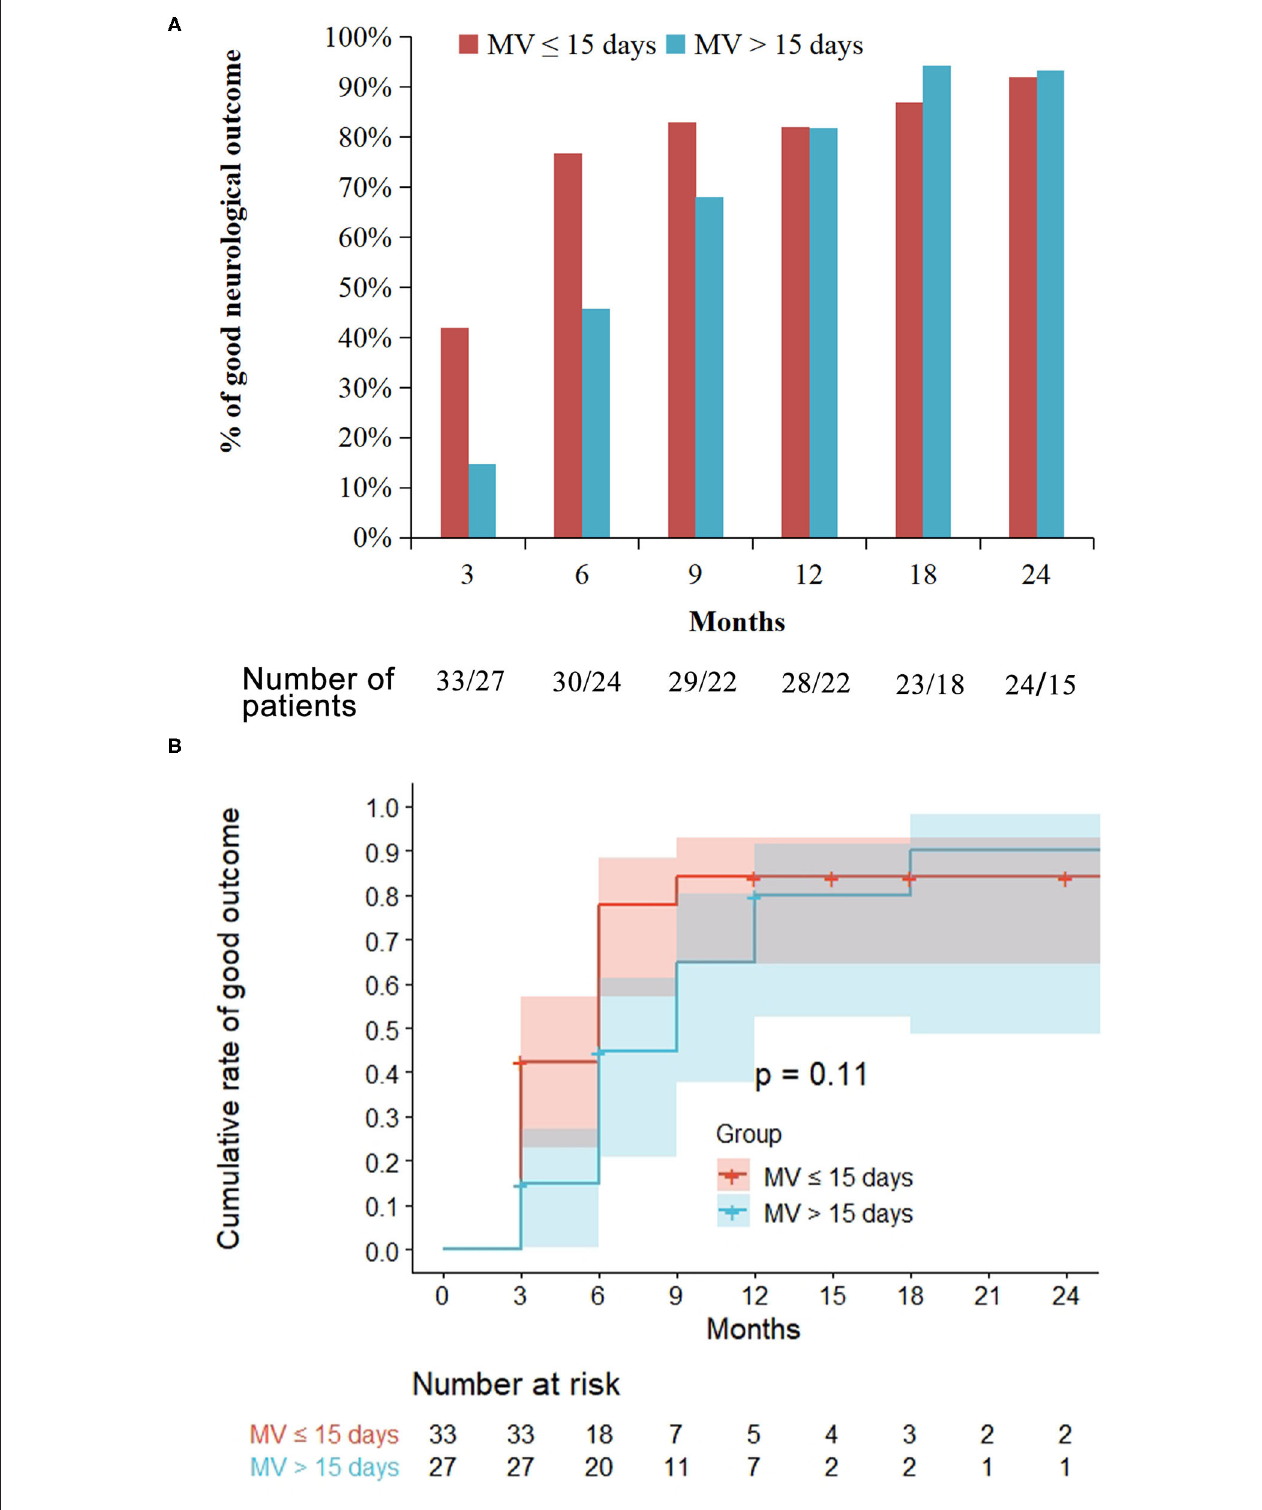
FIGURE 3 | Treatment outcome in the prolonged mechanical ventilation (MV) group as compared with the short MV group. Prolonged MV is defined as MV > 15 days while short MV is defined as MV ≤ 15 days. Good outcome is defined as a modified Rankin Scale score ≤ 2. (A) At the 3 and 6 months’ follow-up, the proportion of patients that achieved a good outcome in the prolonged MV group were significantly lower than that in the short MV group ( p = 0.025 and p = 0.02, respectively). (B) Kaplan-Meier curve showed similar probability of long-term good outcomes among the prolonged and the short MV patients.